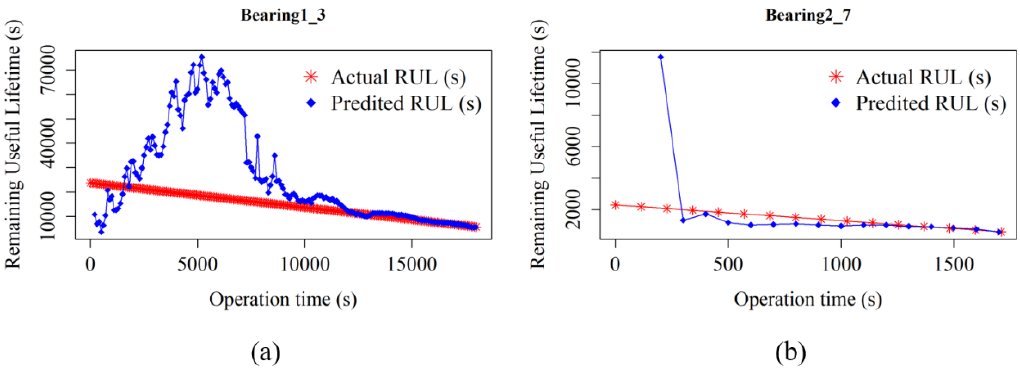
Figure 13. Comparison of the actual RUL and the predicted RUL: ( a ) Bearing 1_3; ( b ) Bearing 2_7.